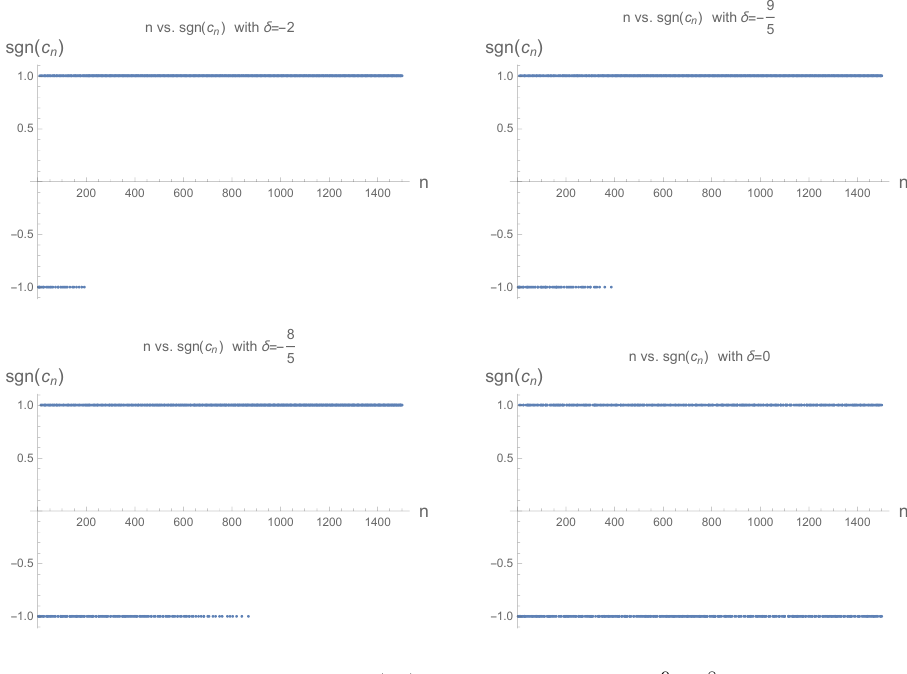
Figure 6 . The n -dependence of sgn ( c n ) for various δ = − 2 , − 9